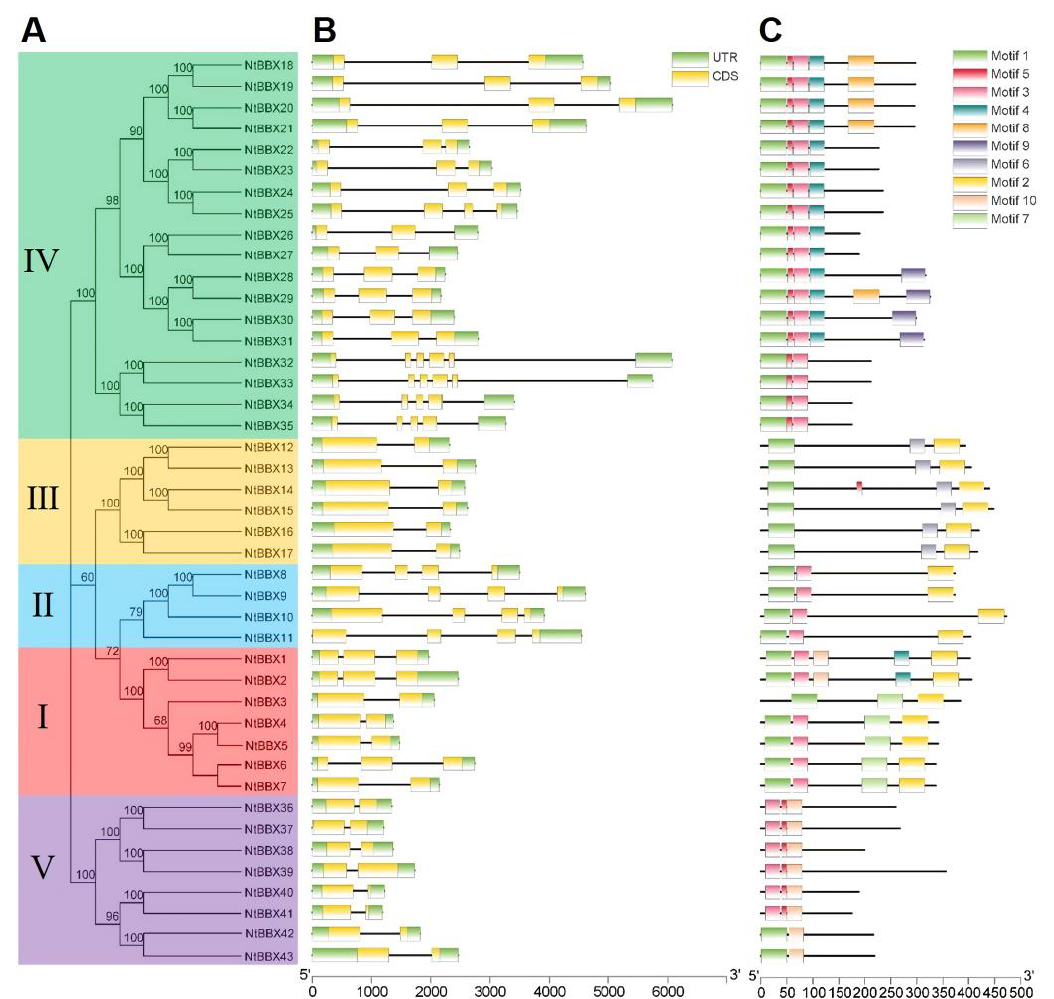
Figure 4. Gene structure and motif of NtBBX gene family. ( A ) Phylogenetic tree of NtBBX proteins sequences from tobacco; ( B ) Gene structure of NtBBX genes. UTR are represented by green boxes, CDS are represented by yellow boxes, and black lines represent intron; ( C ) Motif of NtBBX proteins. Ten different categories of motif are represented by boxes of ten colors. Detailed sequence features of motifs are shown in Supplementary Figure S1.